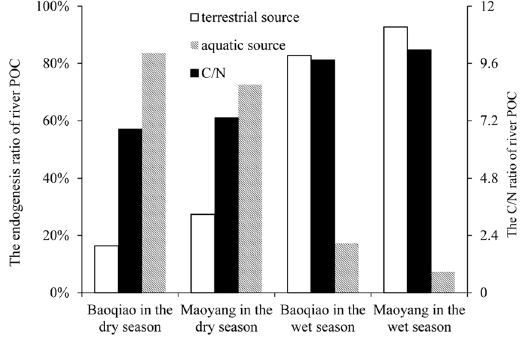
Figure 8. The source and C/N ratios of riverine organic